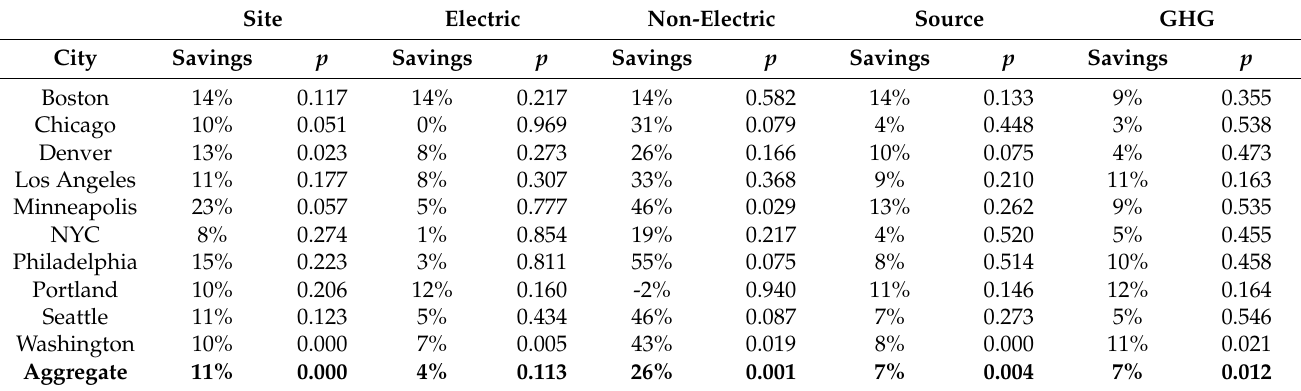
Table 3. LEED savings in the five intensity metrics relative to the area weighted means for non-LEED offices in the same cities. The p -values are 2-sided, calculated using permutation testing with 10,000 replicates. Site Electric Non-Electric